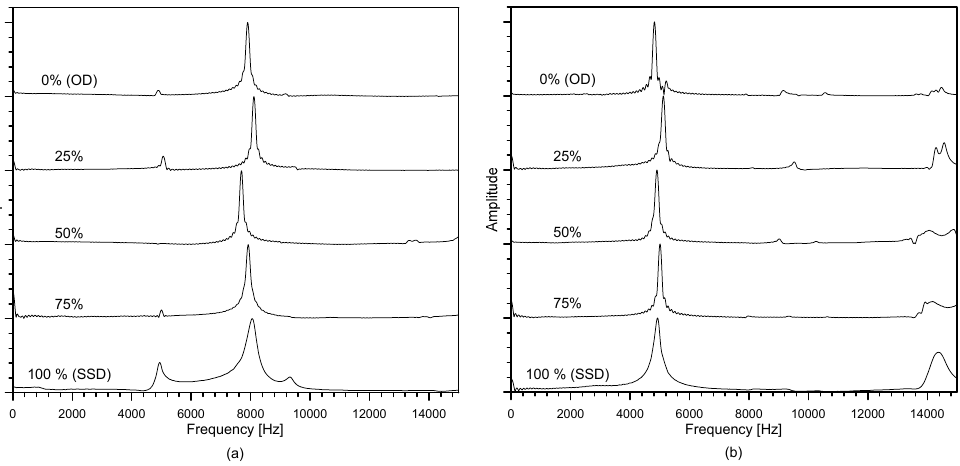
Figure 7. The variations of spectral amplitudes of dynamic response of MIX 1 concrete cylinders in: ( a ) the fundamental longitudinal mode and ( b ) the fundamental transverse mode.